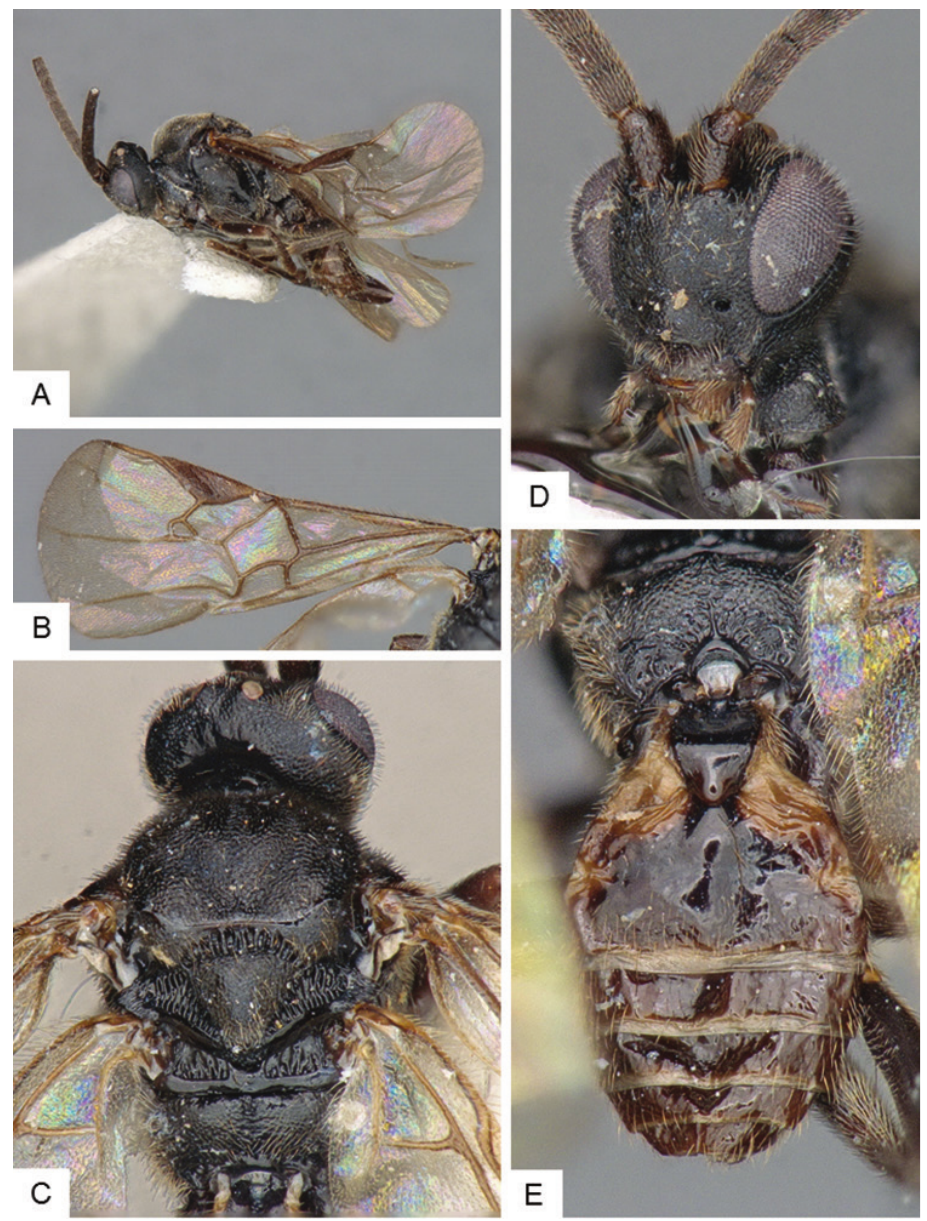
Figure 26. Microplitis coactus . A Habitus, lateral B Fore wing C Head and mesosoma, dorsal D Head, frontal E Metasoma and propodeum,